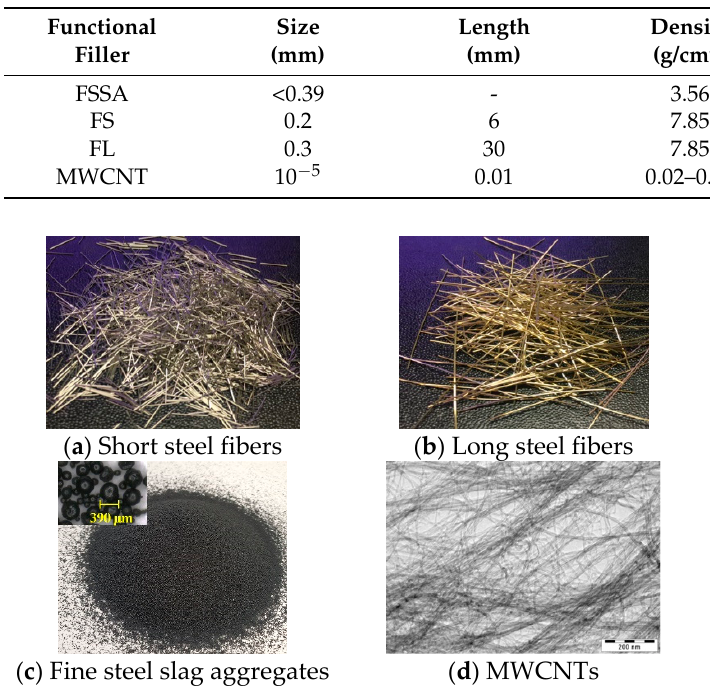
Table 3. Properties of functional fillers.